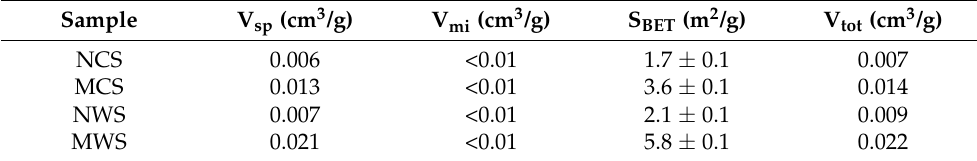
Table 2. Adsorption parameters for native and modified starch